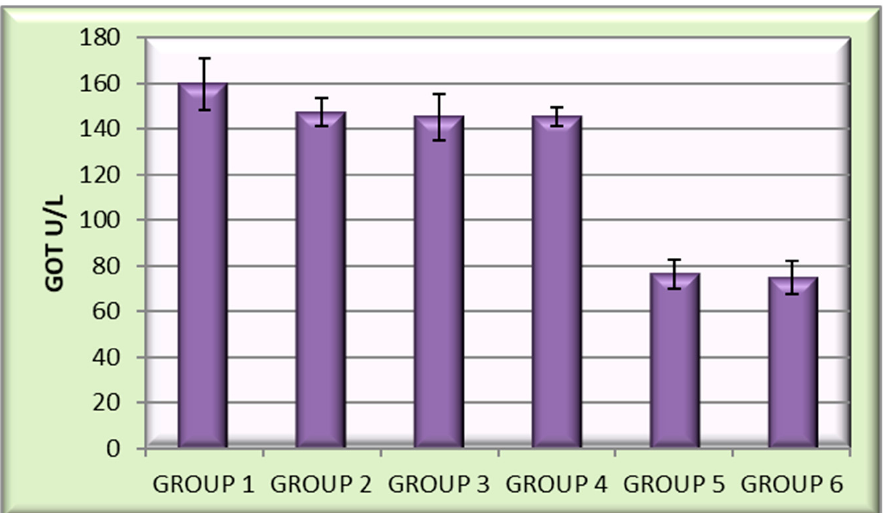
Figure 10. Mean GOT values for the encapsulated samples from the six groups of animals. Alkaline phosphatase (ALP).